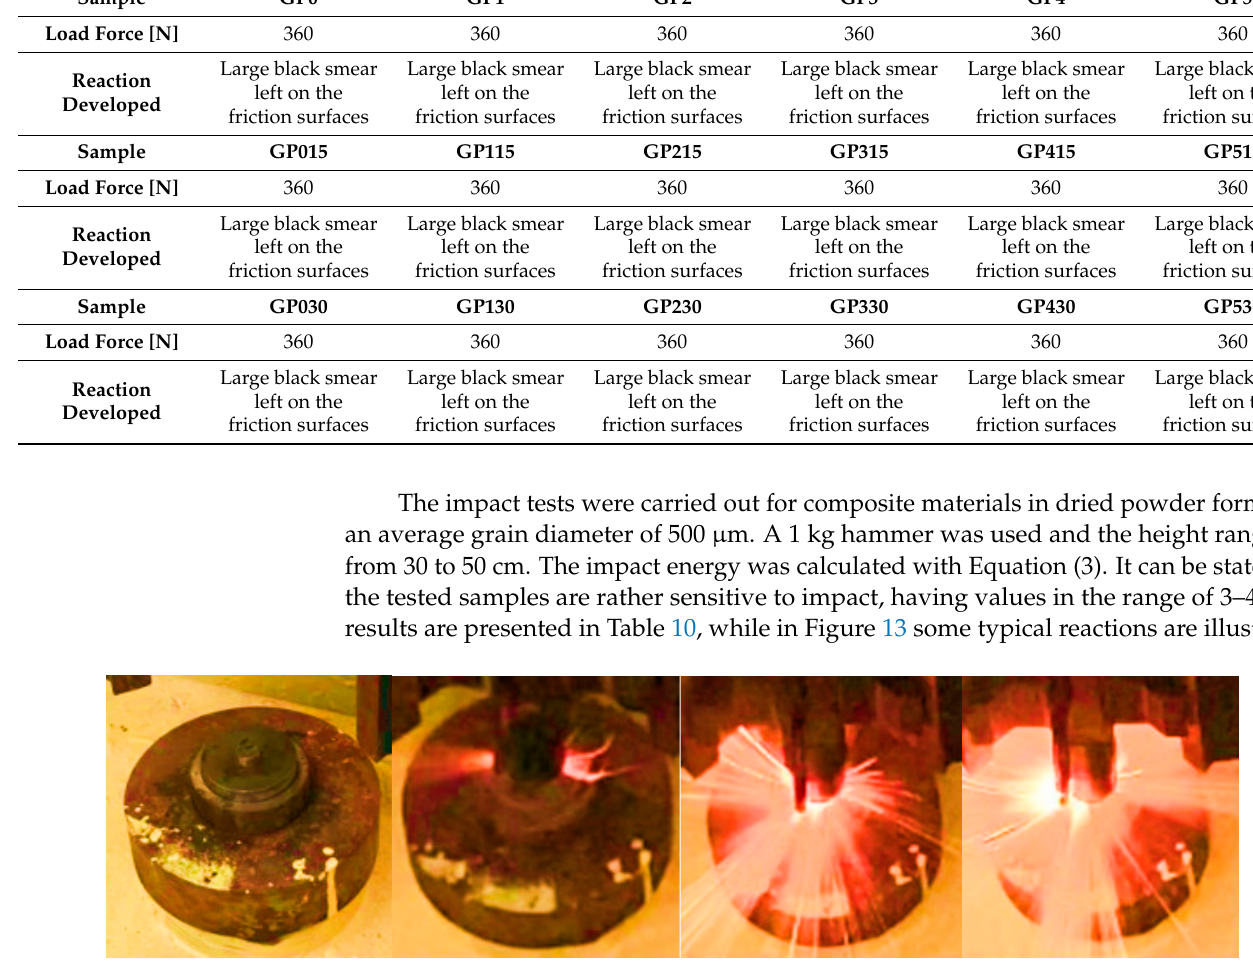
Table 9. Mechanical sensitivity to friction stimuli of “green” formulations.